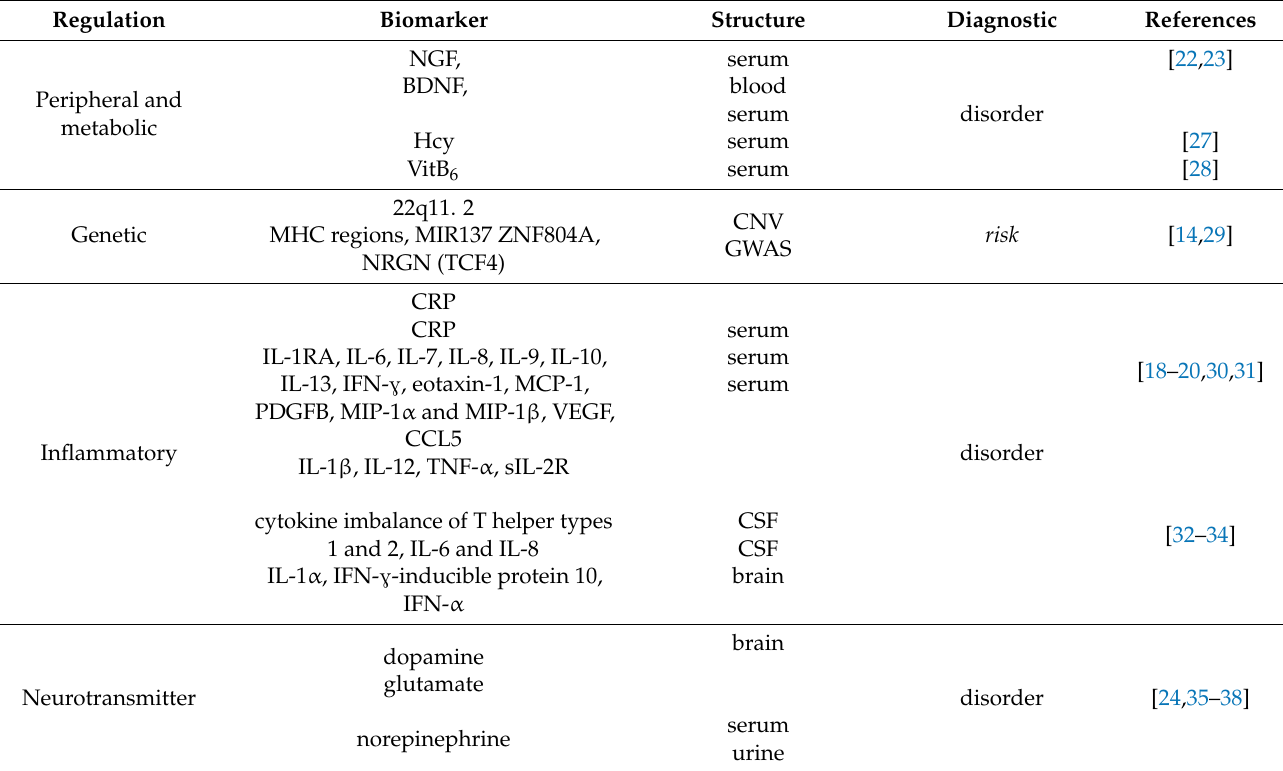
Table 1. Diagnostic and prognostic biomarkers for